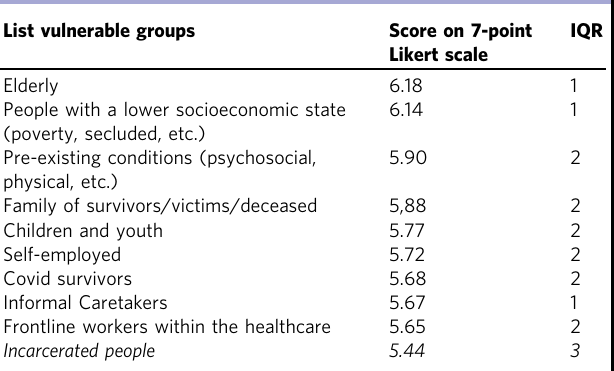
Table 4 Lists vulnerable groups according to the experts — no consensus indicated in italics.